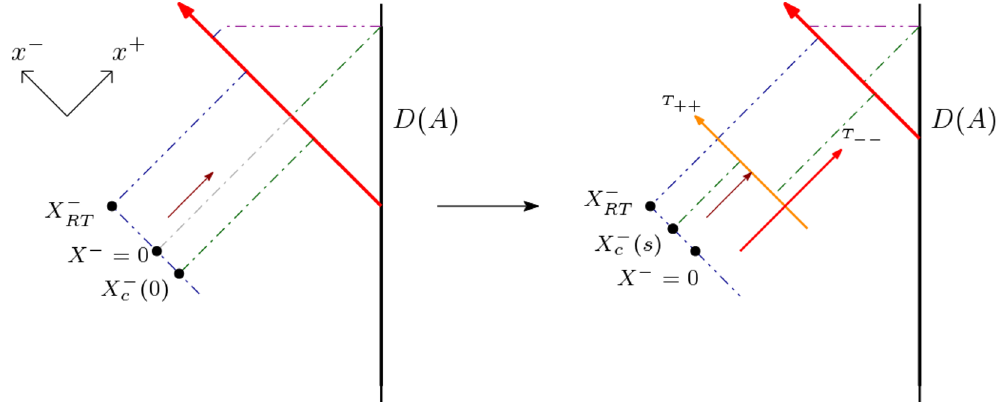
Figure 6 . Schematic representation of a simple case where the gap is sourced by both energy — the red shock — and entanglement — not pictured. In the new state, the energy is boosted up, so that it causes less of a time-delay; and there is an infalling negative energy shock, creating a time-advance to close the entanglement-sourced part of the gap. This is not a Penrose diagram; time-delays and advances are shown as simple changes in position. This is only the leading-order behaviour. Green lines mark causal horizons, red lines mark positive energy shocks, orange lines mark negative energy shocks, and the brown line is a signal leaving the